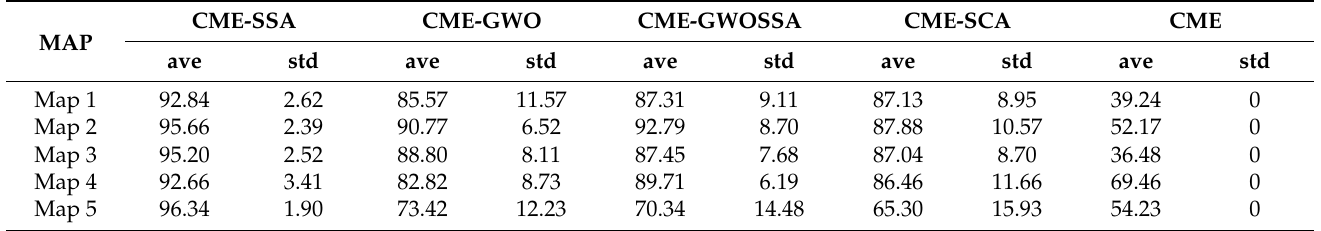
Table 4. Avg and std of the percentage of the explored area in a complex environment for each